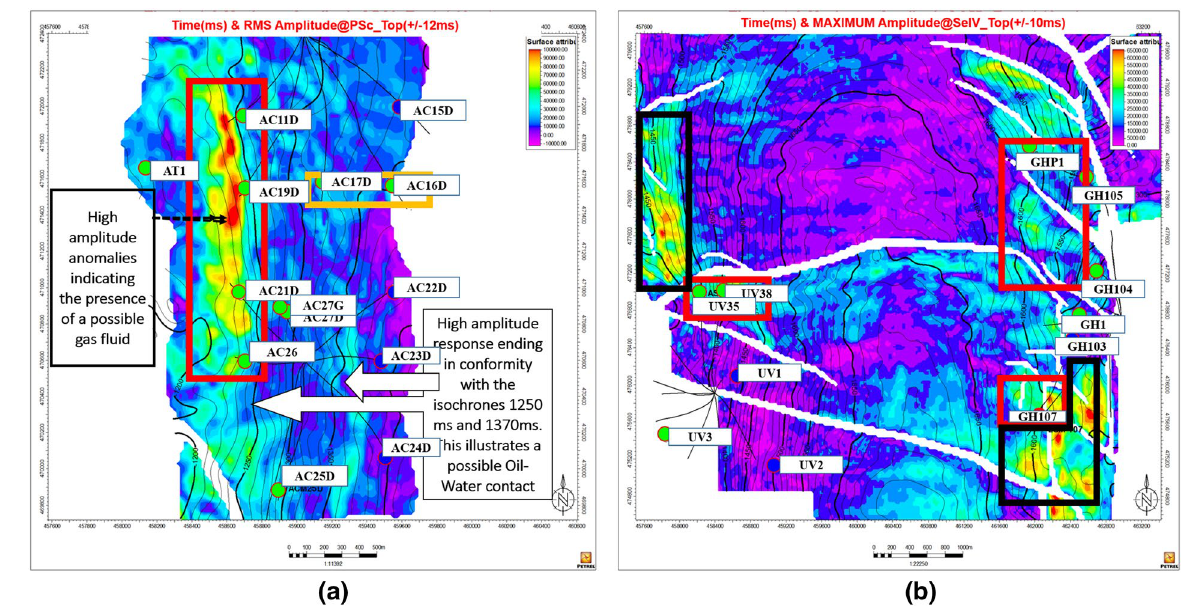
Fig. 9 Reservoir maximum amplitude map a UV PSc; b GH-UV SeIV